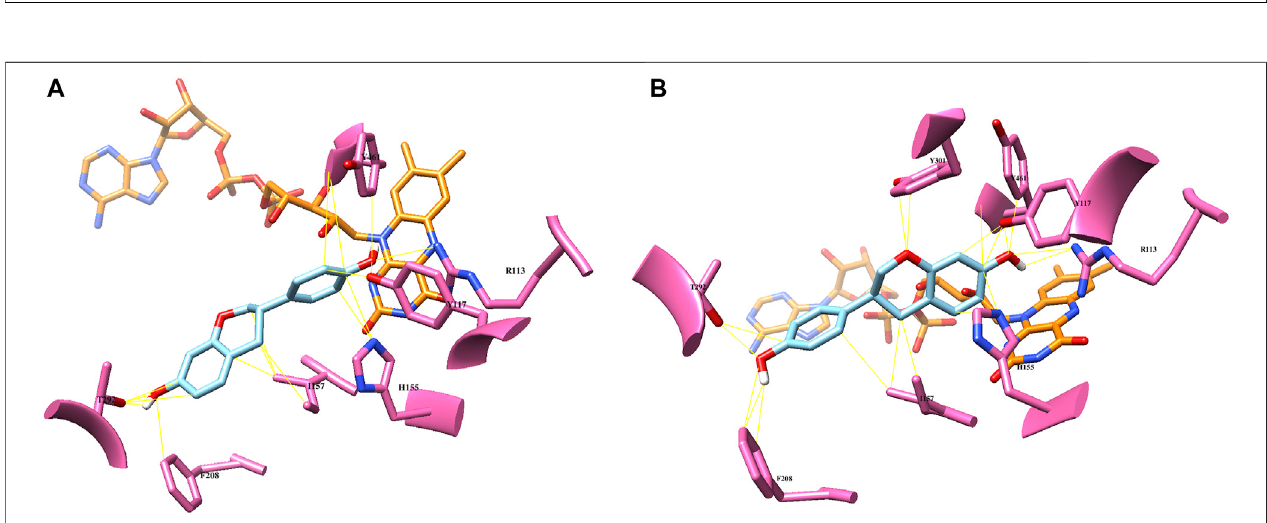
FIGURE 4 | Computational docking analysis of ( S )-equol (cyan) of the crystal structure of Ec HpaB (PDB code: 6QYI) (A) : binding mode of 3 ′ -hydroxylation (B) : binding mode of 6-hydroxylation. Potential substrate binding residues are highlighted with pink, and the FAD cofactor is shown as orange.